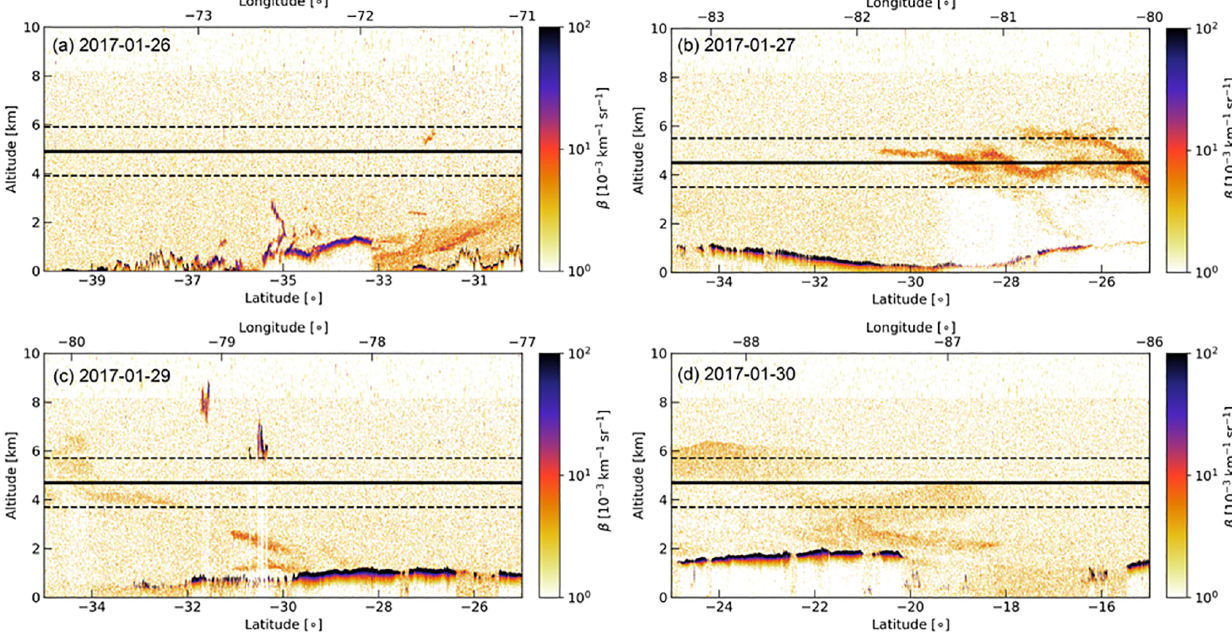
Figure 7. CALIOP backscatter coefficient β at 532nm. The solid and dashed lines indicate the retrieved z aer and (cid:49)z . The red and black dots indicate clouds, and the orange dots indicate aerosol